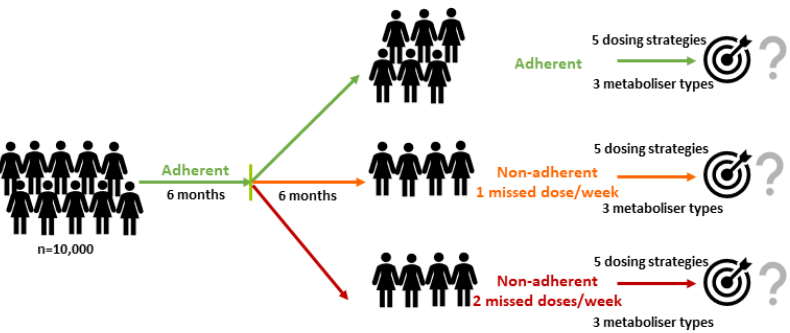
Figure 1. Workflow for the simulation study to assess the impact of two non-adherent scenarios compared to the full adherent scenario (0 missed doses/week, top) on endoxifen target attainment for five different dosing strategies comprising genotype-predicted normal metabolisers (gNM), intermediate metabolisers (gIM) and poor metabolisers (gPM).